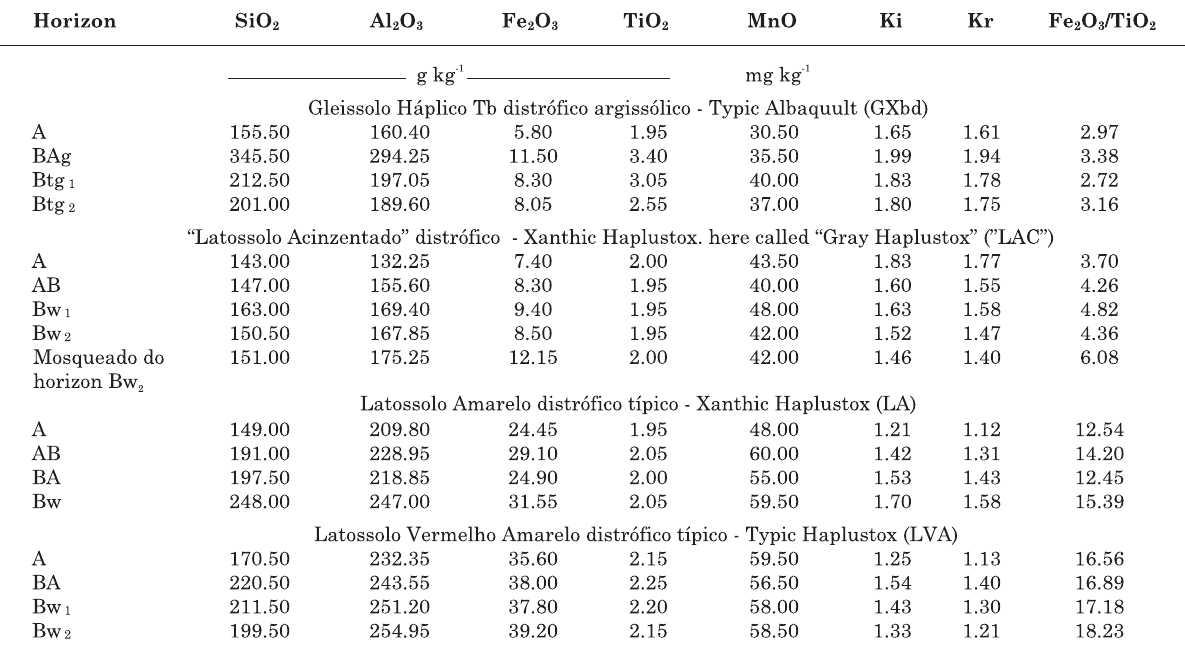
Table 4. Total oxide content resulting from sulphuric attack, Ki and Kr indices, and the Fe soils in the toposequence on the slope of the Lagoa do Leandro swamp